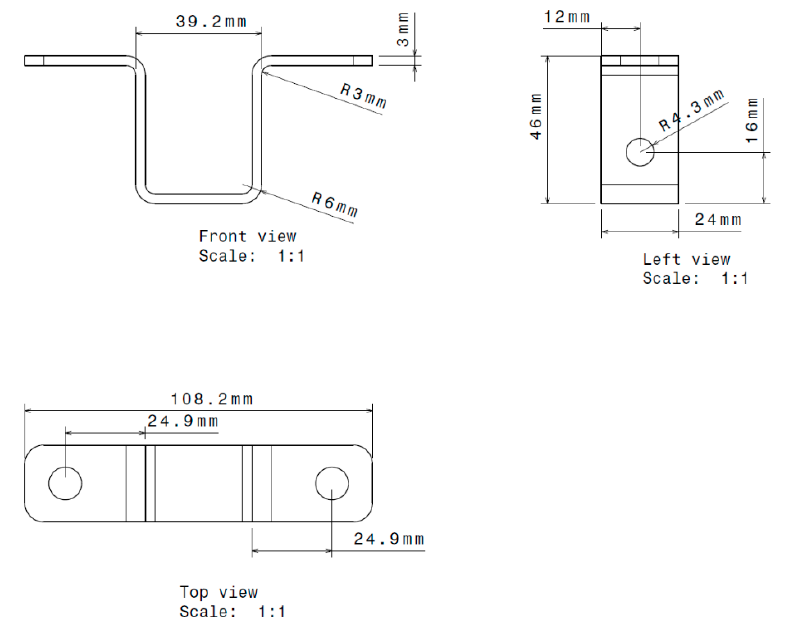
Figure 4. The Dimensions of the Mobile Leaf.